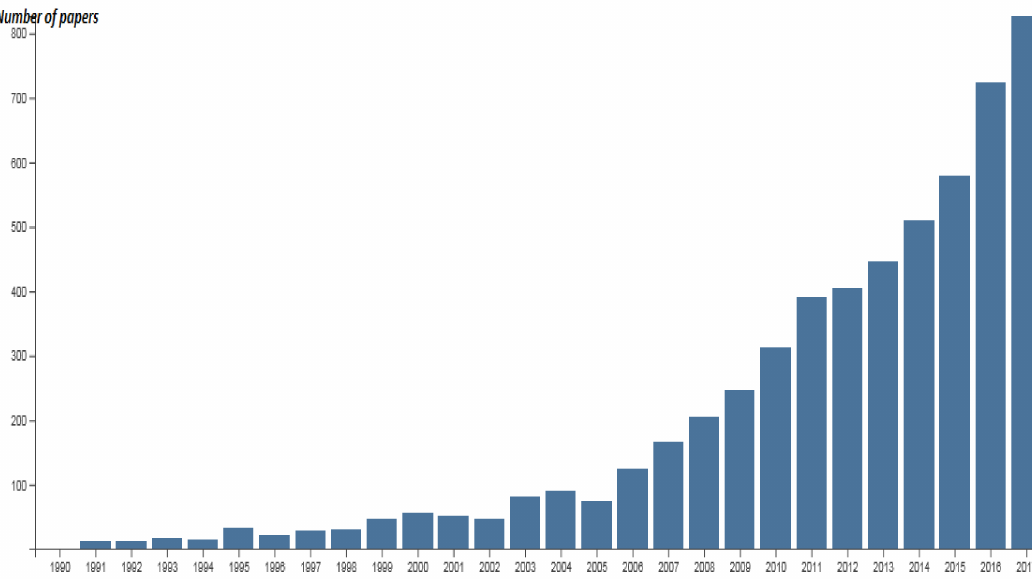
Figure 1. Evolution of the number of papers per year (from 1990 to 2017) published regarding essential oils and